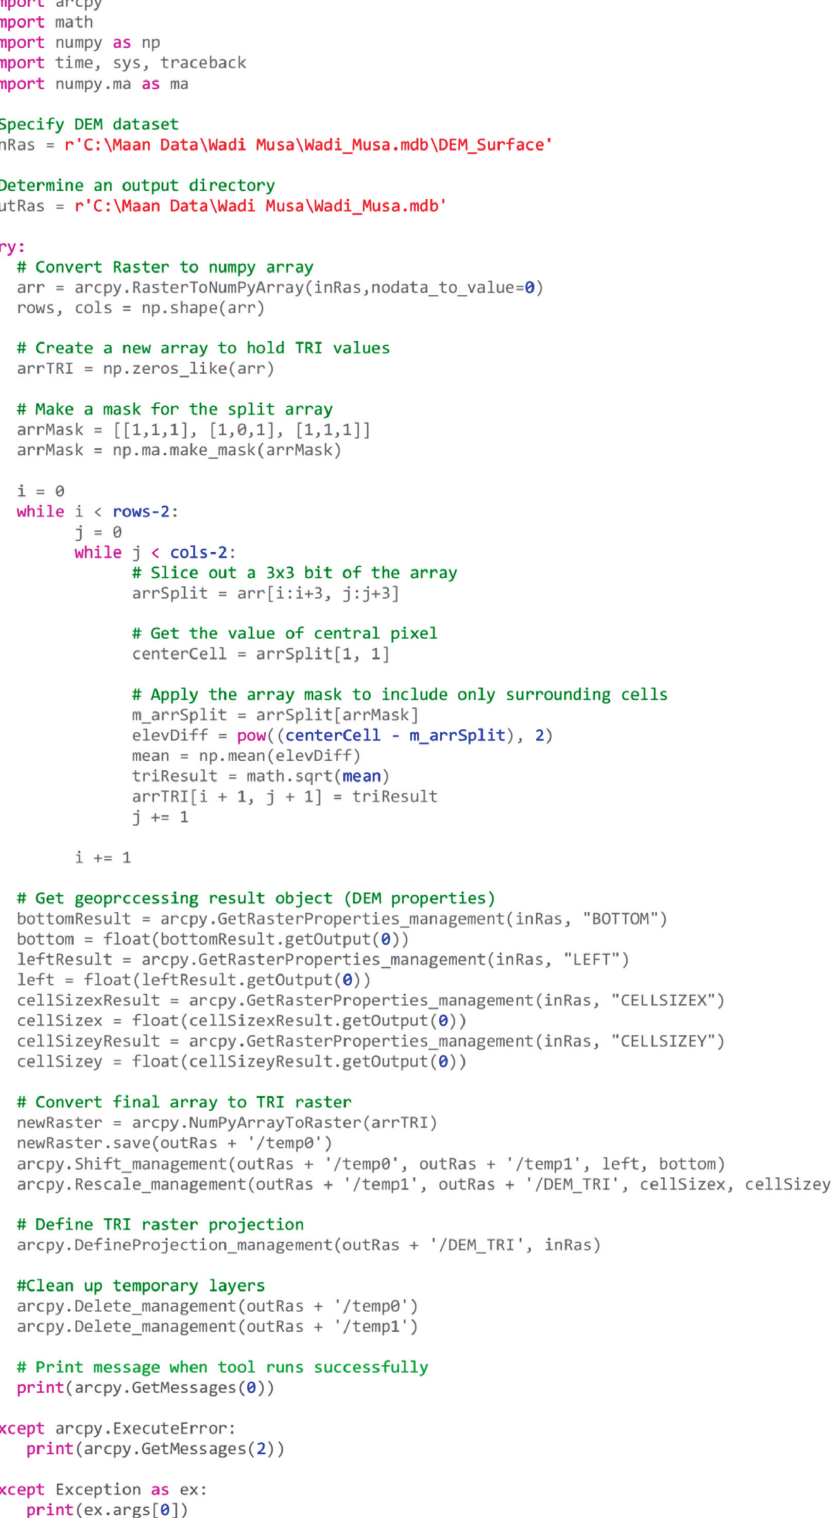
Figure 6: TRI calculator code in Python